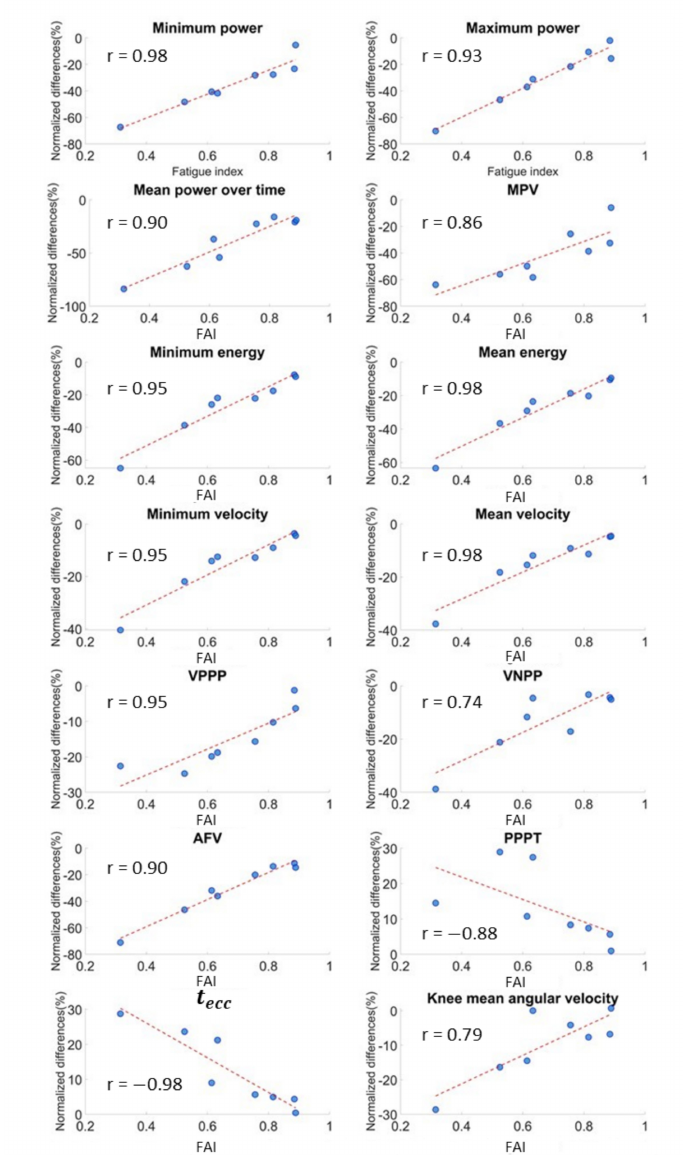
Figure 6. Correlation between fatigue approximation index (FAI) and parameter